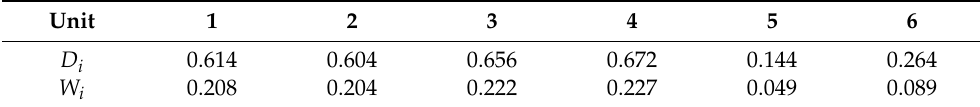
Table 8. Each decision-making unit D i and W i